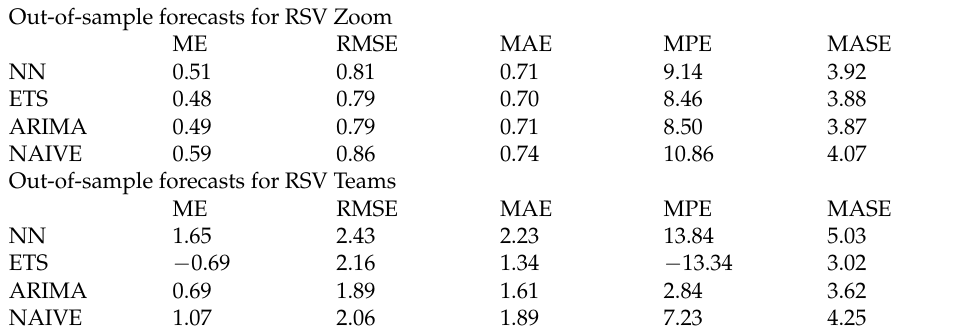
Table 1. Accuracy measures (out-of-sample). Out-of-sample forecasts for RSV